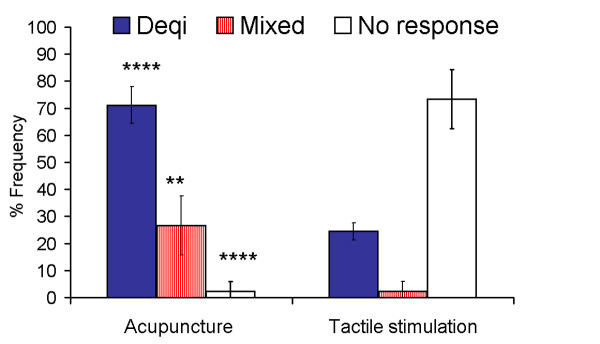
Comparison of the frequency of different categories of psychophysical responses between acupuncture and tactile stimulation control. When thresholded at a score of 3, the pooled data (N = 45) from the three acupoints showed a deqi frequency of 71% for acupuncture compared with 24% for tactile stimulation control (p < 0.0001). Standard error bars are based on a 95% Confidence Interval. Fisher's exact test. **p < 0.01, ****p < 0.0001. For more details on data refer to Table 1.